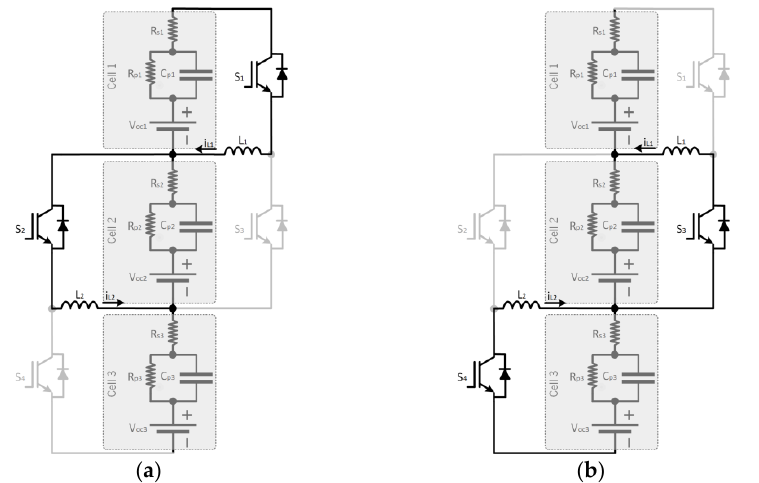
Figure 12. Operating modes of the SwI converter: ( a ) first stage, T 1 ; ( b ) second stage, T 2 .